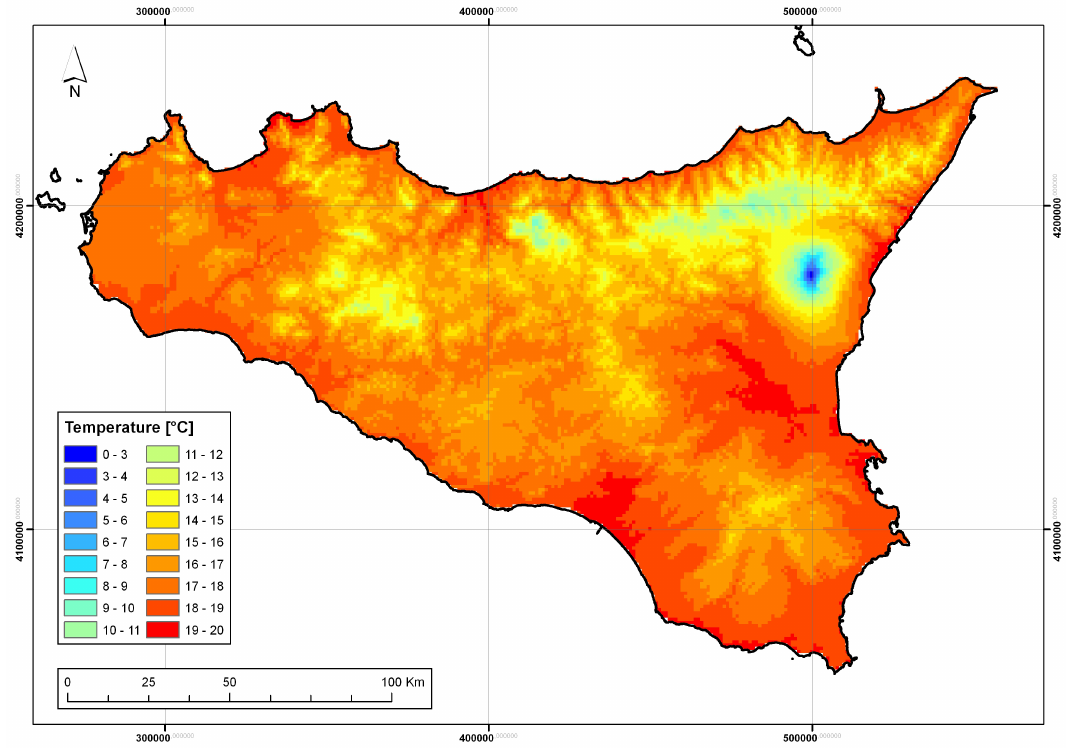
Figure 4. Mean annual temperature interpolated using residual kriging with linear regression (RK-LR) z - q